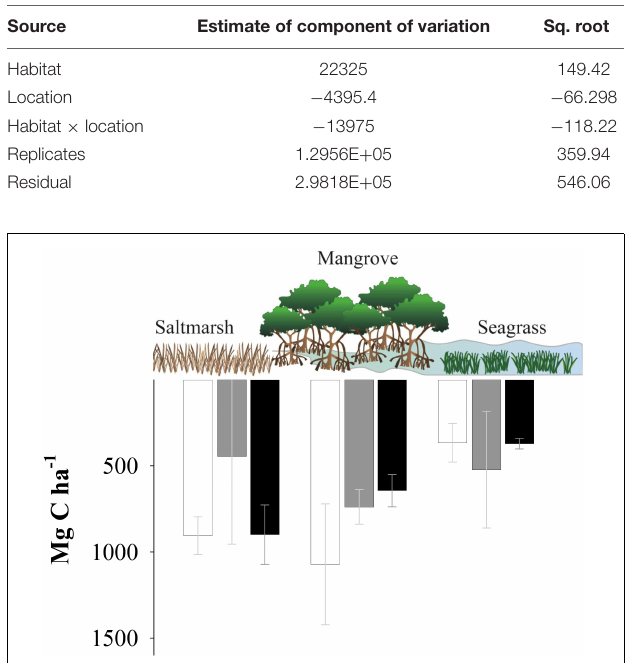
FIGURE 2 | Carbon stocks (Mg C ha − 1 ) of the urbanized Coffs Creek estuary (white), the agriculturally impacted Corindi River estuary (gray) and the pristine Wooli River estuary (black). Data are presented in means while bars represent standard errors. Analysis of variance found no significant differences between habitat type or location.